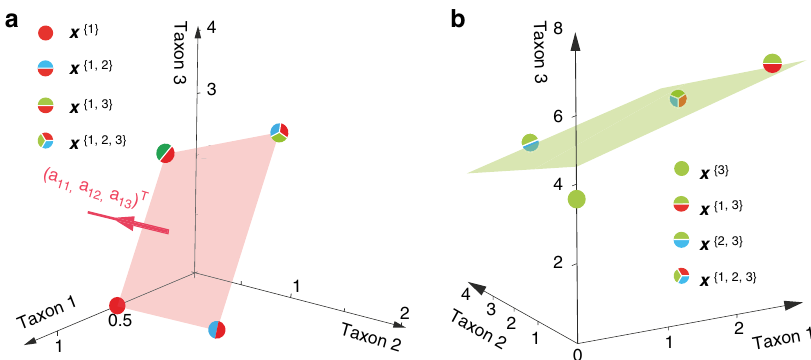
Fig. 2 Consistency check of the GLV model and the observed steady-state samples. For a microbial community following exactly the GLV dynamics, all its steady-state samples sharing one common taxon will align onto a hyperplane in the state space. a Here we consider a microbial community of three taxa. There are four steady-state samples { x f 1 g ; x f 1 ; 2 g ; x f 1 ; 3 g ; x f 1 ; 2 ; 3 g } that share common taxon 1. Those four steady-state samples represent four points in the state space, and they align onto a plane (light red). The normal vector of this plane is parallel to the fi rst row a 1 of the interaction matrix A in the GLV model. Given any one of non-zero entries in a 1 , we can determine the exact values of all other entries. Otherwise, we can always express the inter-taxa interaction strengths a ij ( j ≠ i ) as a function of the intra-taxa interaction strength a ii . b Here we again consider a microbial community of three taxa. Taxon-1 and taxon-2 follow the GLV dynamics, but taxon-3 does not. Then those steady-state samples that share taxon-3 do not align onto a plane anymore. Here we show the best fi tted plane (in green) by minimizing the distance between this plane and the four steady states, with the coef fi cient of determination R 2 ¼ 0 : classical GLV model can be obtained from Eq. (1) by choosing